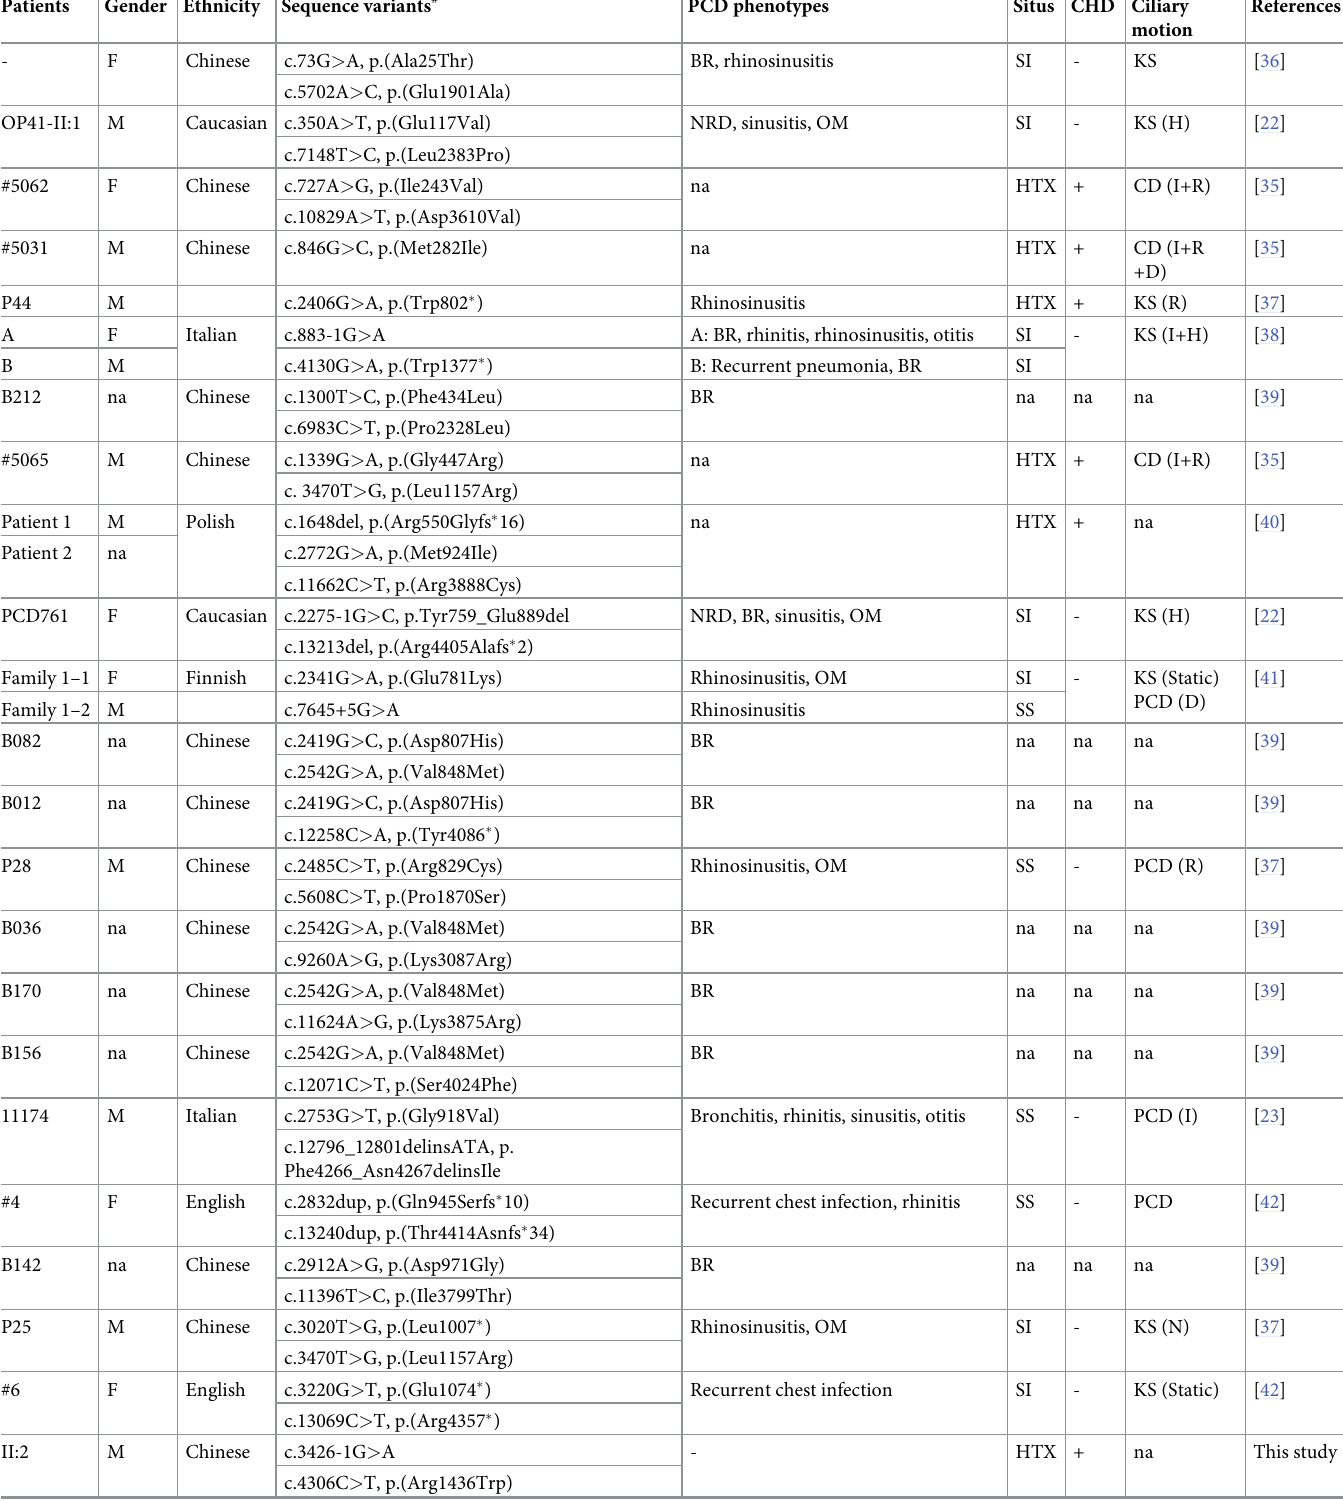
Table 1. Clinical phenotypes of individuals with DNAH11 compound heterozygous variants.